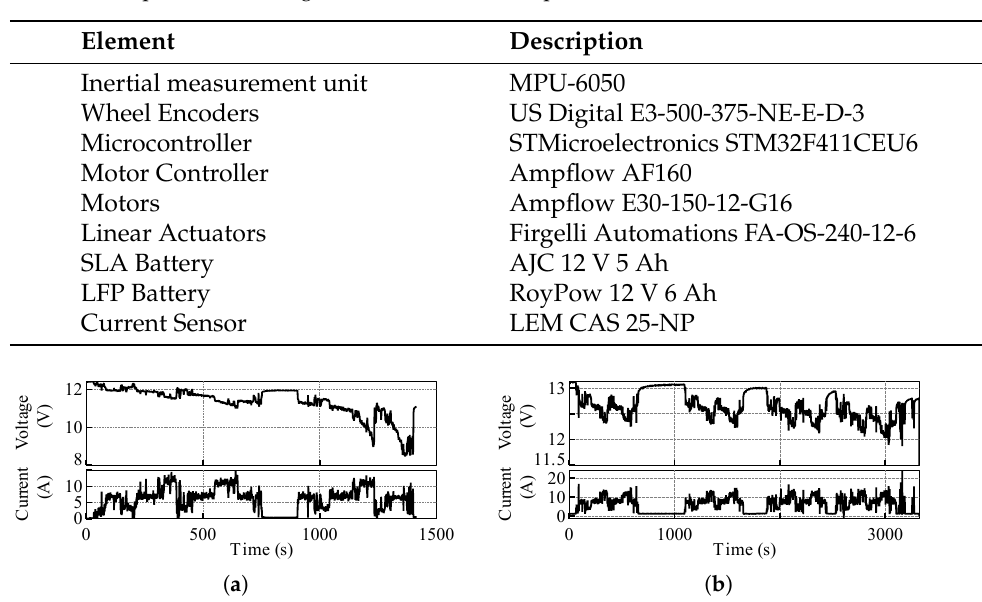
Table 2. Components of the agricultural robot mobile platform.